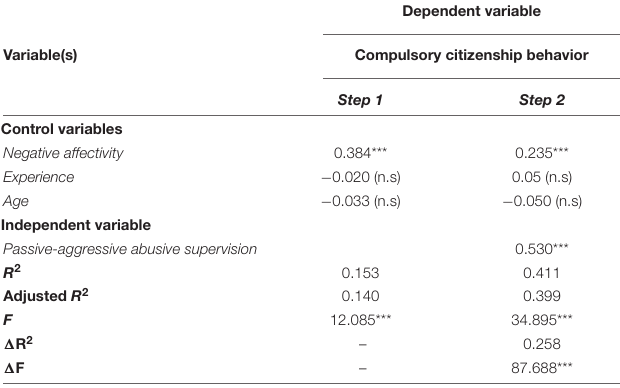
TABLE 3 | Regression analysis with passive-aggressive abusive